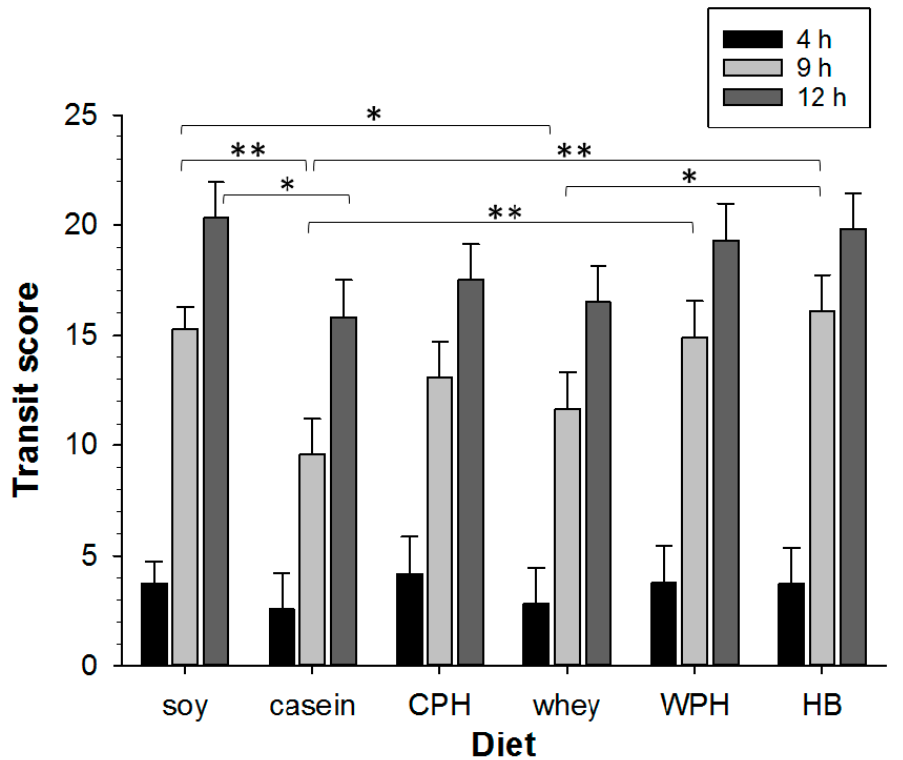
Figure 4. Comparison of GI transit tracked over 12 h for animals treated with soy or milk protein diets ( n = 1–14 animals per group). Transit scores are shown at 4 h (black), 9 h (light grey), and 12 h (dark grey) for: soy, casein, hydrolyzed casein (CPH), whey, hydrolyzed whey (WPH), and hydrolyzed blend (HB). Asterisks indicate the significance of each treatment relative to controls (* p < 0.05; ** p < 0.01). Data show mean ± SEM.